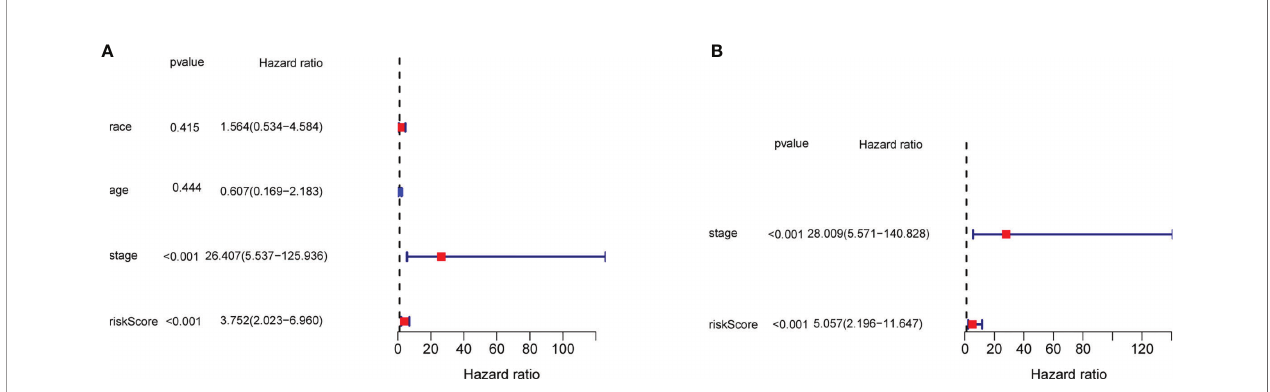
FIGURE 6 | The results of the univariate and multivariate Cox regression analyses regarding signi fi cant survival-related clinical characteristic parameters in TCGA. (A) The forest plots for univariate Cox regression analysis show that risk score (high risk vs. low risk) and AJCC stage (stages I and II vs. III and IV) were prognostic